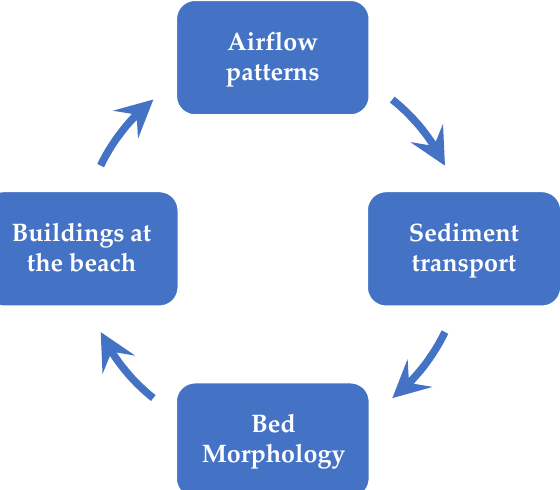
Figure 2. Morphological loop indicating the interactions between buildings at the beach, airflow patterns, sediment transport and bed morphology.